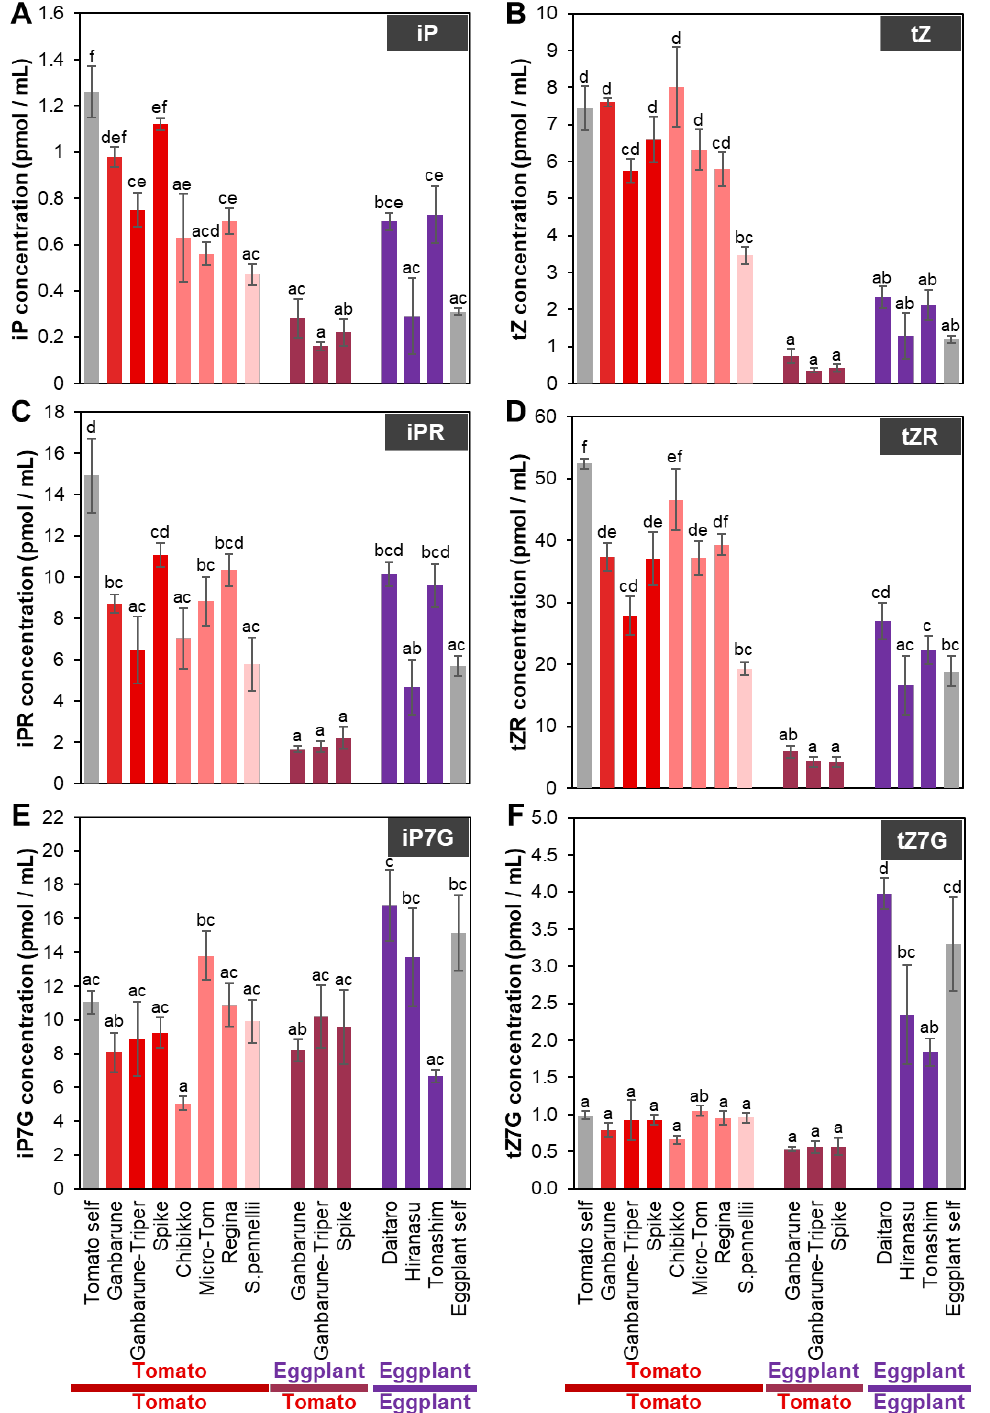
Figure 4. The concentration of CKs in the xylem exudates of various grafting combinations. The concentrations of N 6-( ∆ 2-isopentenyl)-adenine (iP) ( A ), iP riboside (iPR) ( B ), iP-7-N-glucoside (iP7G) ( C ), trans-zeatin (tZ) ( D ), tZ riboside (tZR) ( E ), and tZ-7-N-glucoside (tZ7G) ( F ) in the xylem exudates of various grafting combinations. Gray, red, red–pink, pink, red–purple, and purple indicate self-grafted plants, tomato grafted onto various rootstocks of tomato cultivars, tomato grafted onto various dwarf tomato cultivars, tomato grafted onto wild tomato, eggplant grafted onto various tomato cultivars, and eggplants grafted onto various eggplant cultivars, respectively. Different letters indicate significant differences according to the Tukey-Kramer test ( p ≤ 0.05). Values are the means of four replicate samples, and error bars indicate the standard error of the four replicate